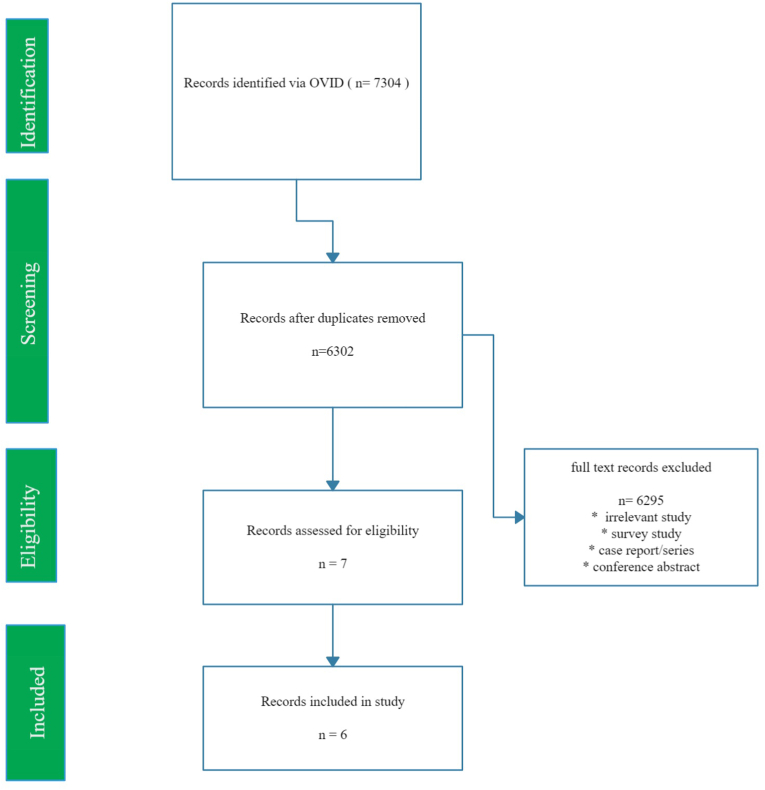
PRISMA Flow chart